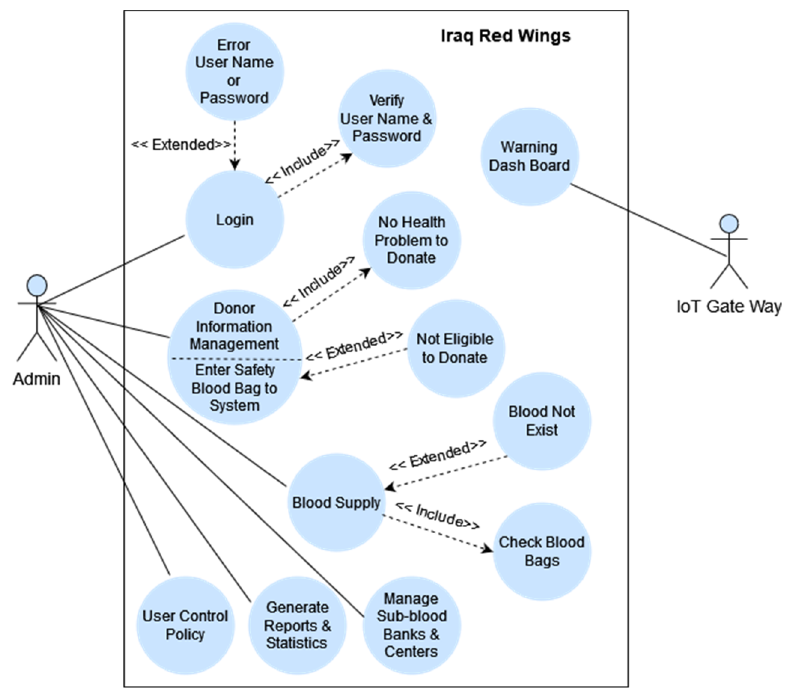
Figure 4. The use case diagram of the proposed system.